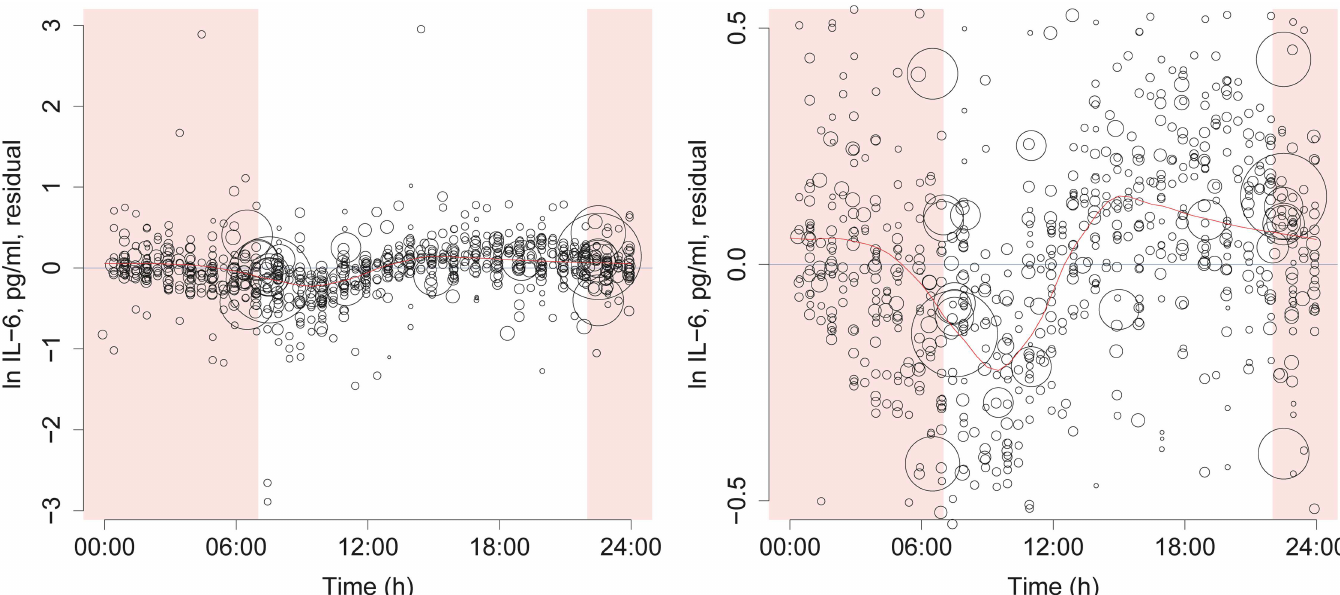
Fig 3. Residuals from null model. Data points sized by regression weight. In the null model, a random intercept for each study and a linear effect of time from catheterization have been included. Therefore, these residualsshow the putative diurnalvariationto be modeled. To explore this variation, we fitted a weightedLOESS curve (red line). This curve shows a trough in the morning. Note that the shapeof the LOESS curve depends on the smoothingparameter. It is therefore possibleto generatedifferent LOESS curves from the same data, and not all of them show a peak in the early afternoon.The LOESS curve was fitted on three repeateddays of the same data, and the curve for the second day shown, to ensure that the estimates wouldmeet at 00:00 and 24:00. Time from 22:00 to 07:00 is shadedto indicatethe night. Left: All data points shown. Right: Y axis range restricted to increase